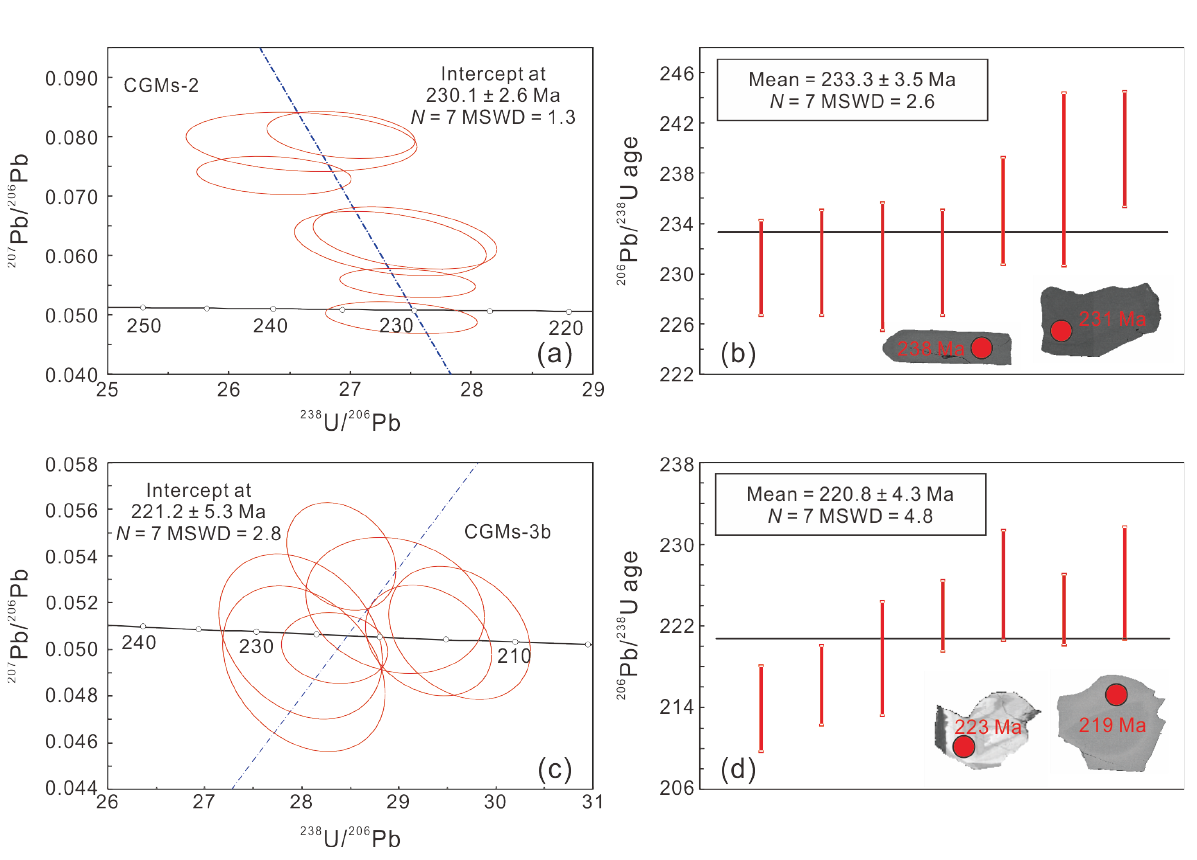
Figure 8. Tera-Wasserburg ( a ) and weighted average ( b ) diagrams for CGMs-2. Tera-Wasserburg ( c ) and weighted average ( d ) diagrams for CGMs-3b. Red circles and red words on the BSE images of typical CGM crystals showing U-Pb analyzed sites and results ( 206 Pb/ 238 U ages), respectively.